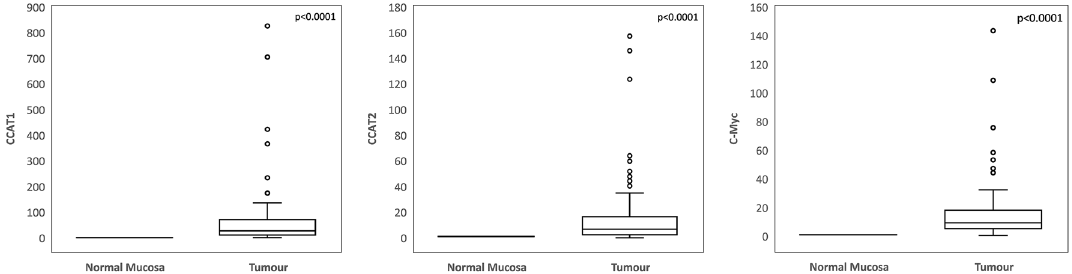
Figure 1. Boxplots of CCAT1 , CCAT2 and c-MYC expression between matched mucosa and